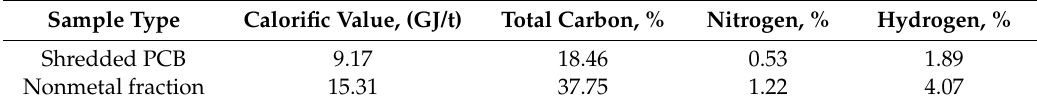
Table 1. Calorific value for shredded PCB and nonmetal